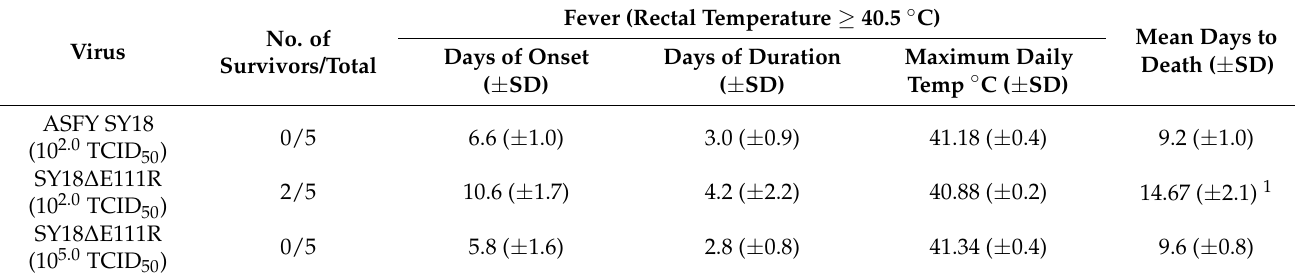
Table 2. Survival and fever responses of pigs infected with SY18 ∆ E111R and ASFV SY18. No. of Virus